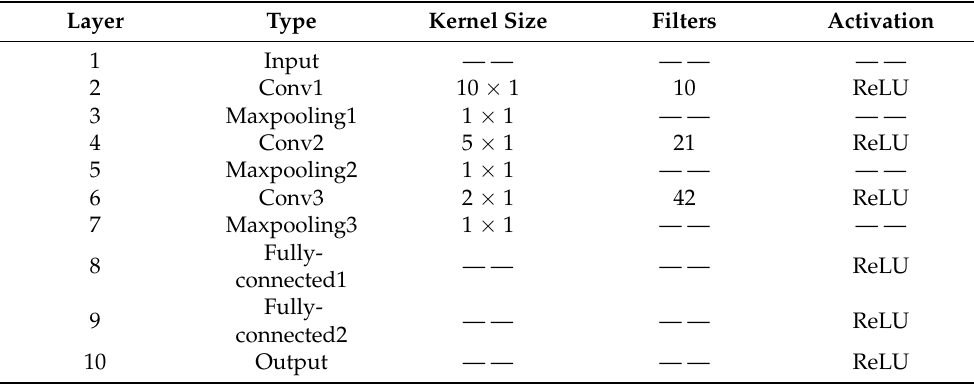
Table 1. Sequence and description of the layers used in the CNN